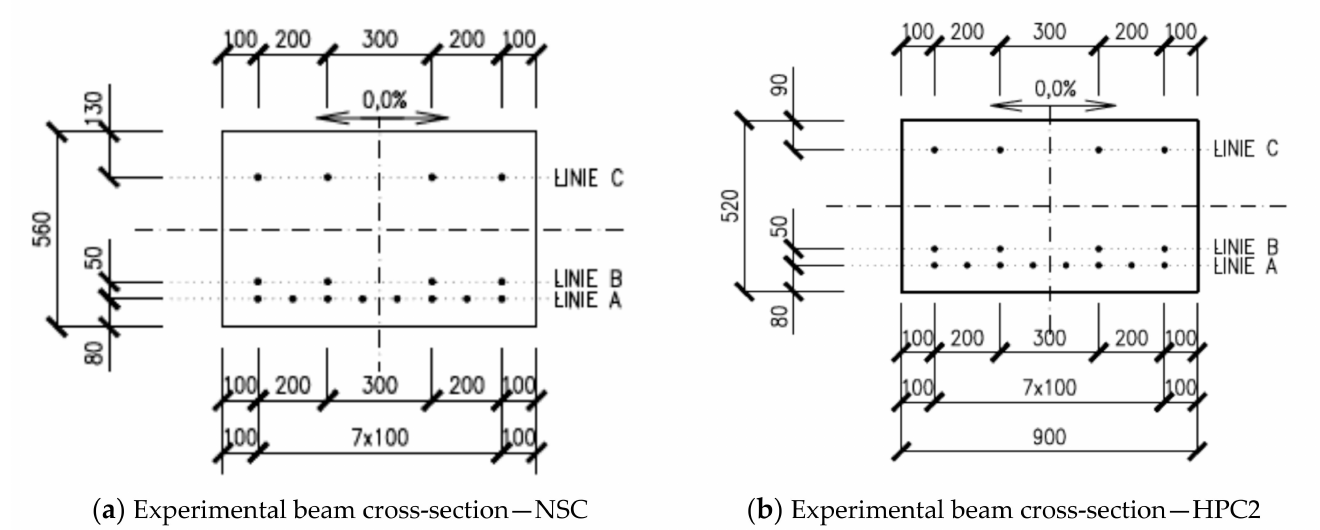
Figure 6. Dimensions of experimental beams’ cross-section, and layout of pretensioned reinforcement: cross-section of NSC beam ( a ), and cross-section of HPC2 beam ( b